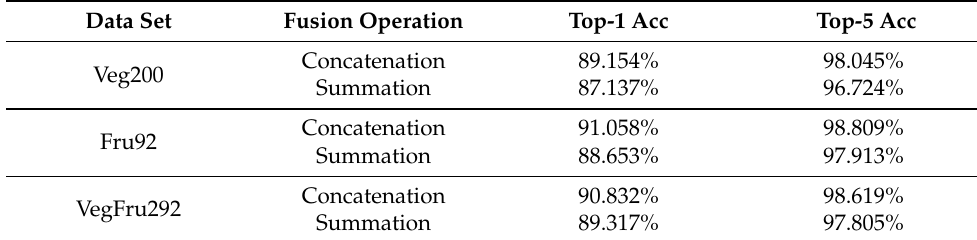
Table 1. An evaluation of different fusion